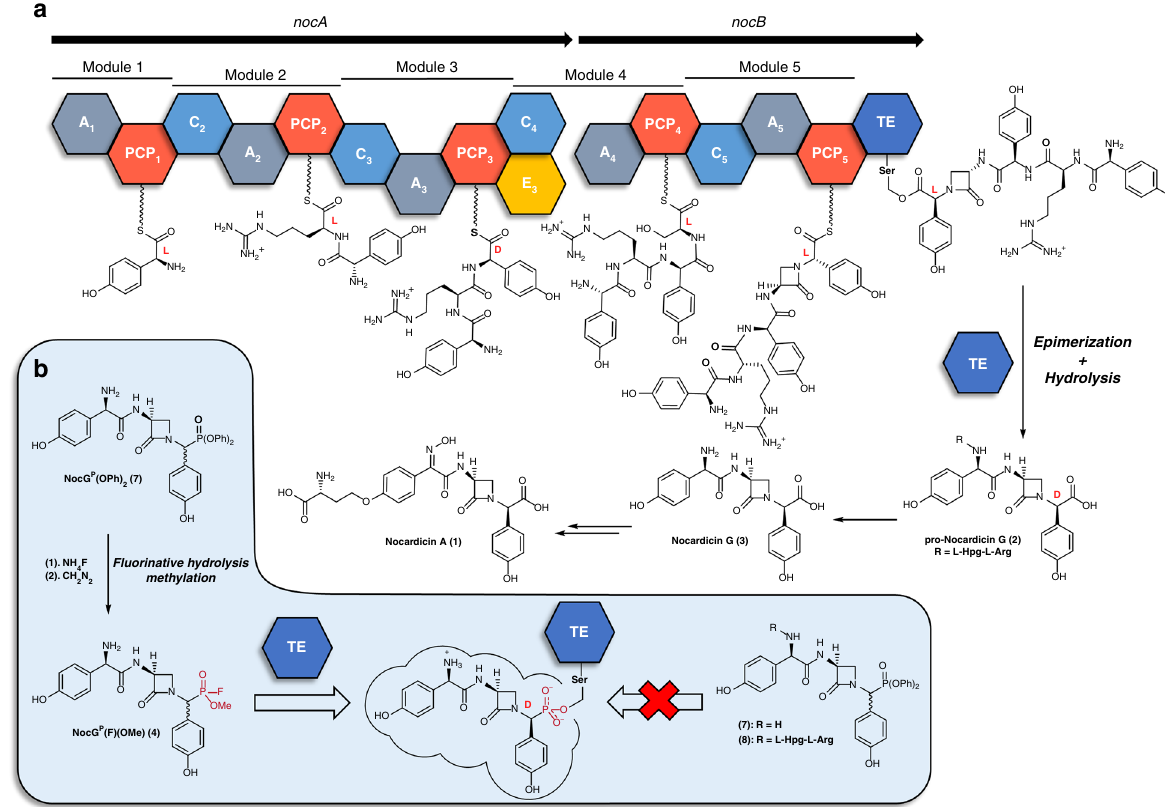
Fig. 1 Nocardicin biosynthetic pathway. a Nocardicin biosynthesis is initiated through the activities of fi ve modules spanning two proteins, NocA and NocB. The fi nal steps in the release of the pro-nocardicin G pentapeptide are carried out by the bifunctional thioesterase domain (NocTE), which catalyzes both epimerization of the C-terminal Hpg residue and hydrolysis. b Whereas diphenylphosphonate analogs did not react with the catalytic nucleophile of the thioesterase domain, a fl uorophosphonate tripeptide analog 4 inactivated the enzyme and was used in structural studies to characterize the active